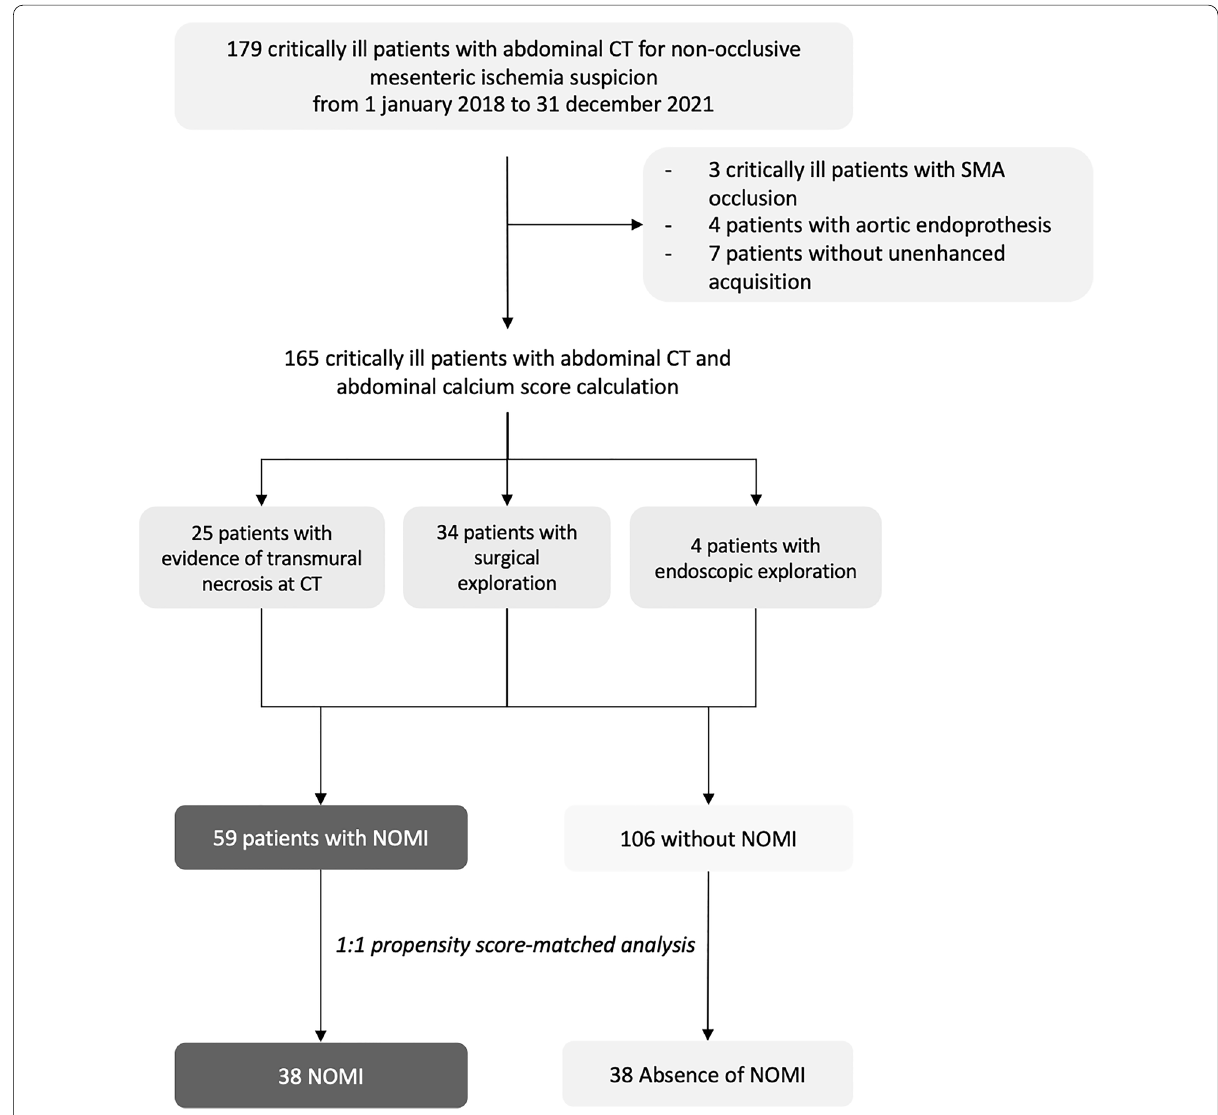
Fig. 1 Flow chart of the study